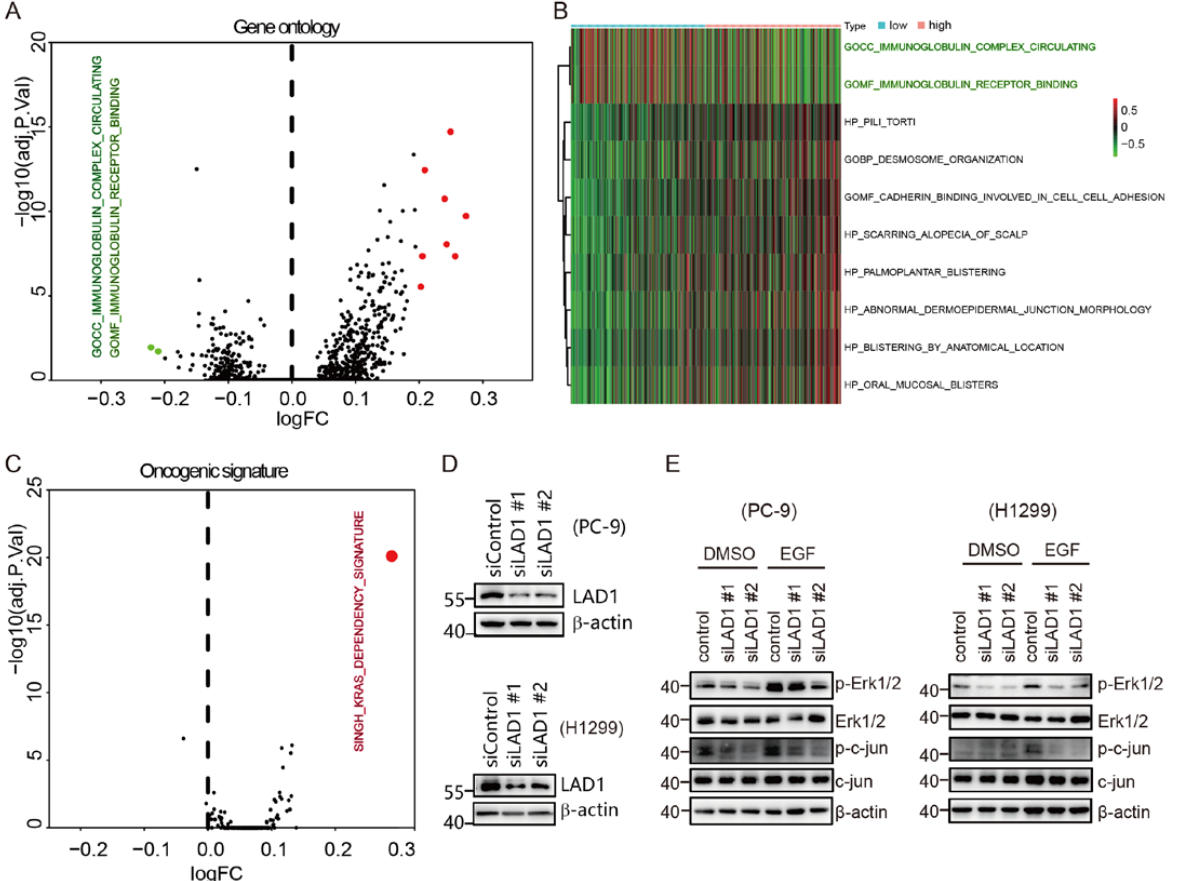
Figure 5. GSVA analysis revealed differences in gene ontology categories and oncogenic signatures between LAD1 high-expression and low-expression groups. ( A ) The differences in gene ontology categories between the LAD1 high- and low-expression groups shown by a volcanic map. ( B ) The heatmap shows the gene ontology categories that differ significantly. ( C ) The differences in oncogenic signatures between the LAD1 high- and low-expression groups shown by a volcanic map. The SINGH_KRAS_DEPENDENCY_SIGNATURE was the only oncogenic signature with a significant difference. ( D ) LAD1 knockdown by two small interfering RNAs (siLAD1 #1 and siLAD1 #2) in PC-9 and H1299 was examined by Western blot. ( E ) The levels of ERK1/2, c-jun, phosphorylated ERK1/2, and c-jun were examined in control and LAD1-knockout PC-9 cells, with or without EGF treatment.